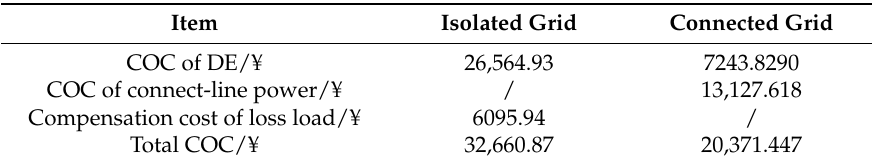
Table 2. Comparison of simulation